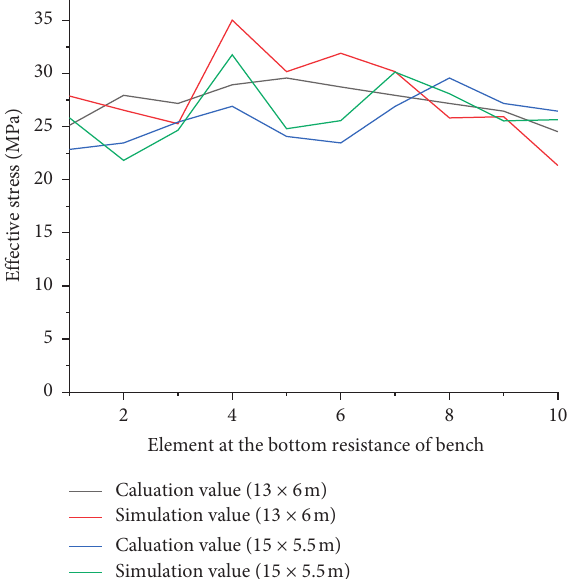
Figure 14: Effective stress of the section at the bottom resistance of bench.